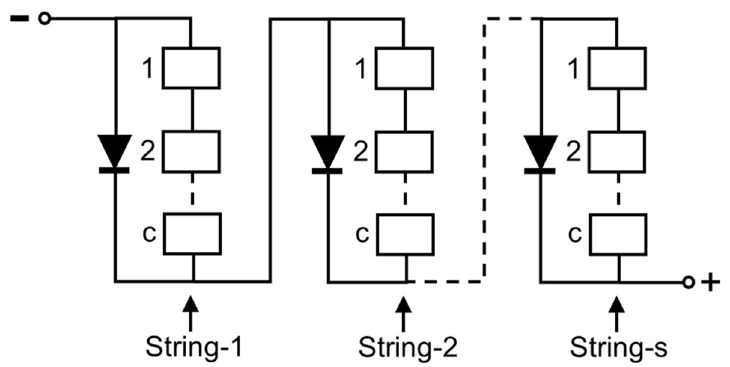
Figure 8. A configuration of a PV module shown as an example to illustrate the voltage calculations. The module consists of a total of s strings with each string consist of c solar cells. Once the five parameters of the PV module under the non-shading condition are determined from its experimental I-V curve, the corresponding parameters for single cells are derived from dividing the obtained values of R s and R sh by the number of total cells in the module [48]. Subsequently, the parameters of the shaded cell or cells are adapted to the actual shading condition, using Equations (3)–(7). The voltage of each cell (V cell ) is then calculated, based on its photo-generated current (I ph,cell ), which depends on the shading percentage, from a piecewise approach presented in [21,26] and can be described using the single diode five-parameter model by: